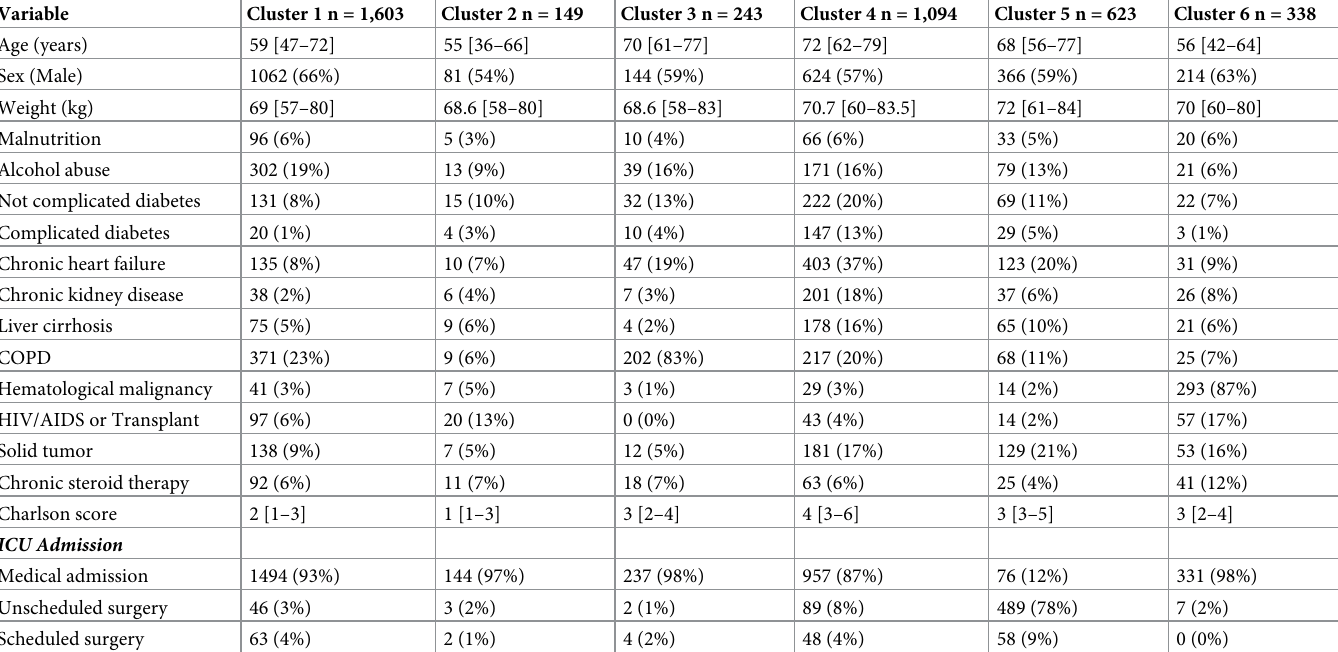
Table 1. Host characteristics by cluster (performed in training